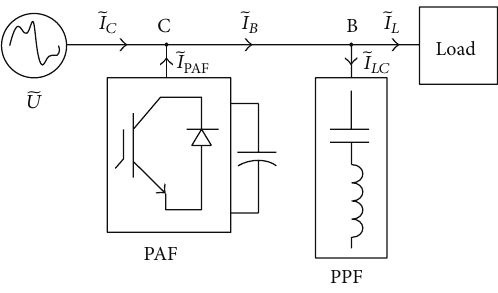
Figure 3: Architecture of the